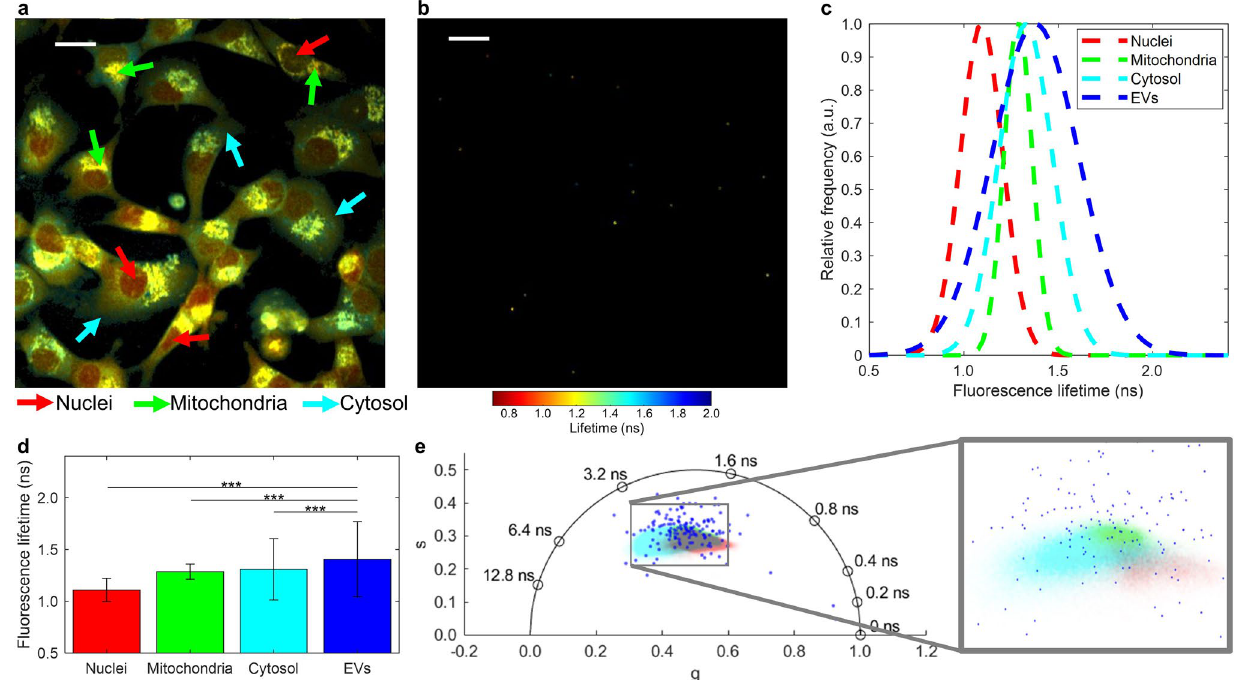
Figure 5. FLIM signature of extracellular vesicles (EVs) and the cellular components of their parent cells. ( a ) Fluorescence lifetime-weighted image of MDA-MB-231 cells with corresponding arrows for nuclei ( red ), mitochondria ( green ), and cytosol ( cyan ). ( b ) Fluorescence lifetime-weighted image of EVs. Color bar for FLIM images given in ns. ( c ) Fluorescence lifetime Gaussian fits of major cellular components and EVs. ( d ) Bar chart showing mean and standard deviation of fluorescence lifetime distributions. *** indicates P < 0.001. ( e ) Phasor plot showing the phasor components of EVs ( blue ) and the cellular nuclei ( red ), mitochondria ( green ), and cytosol ( cyan ). Scale bars represent 20